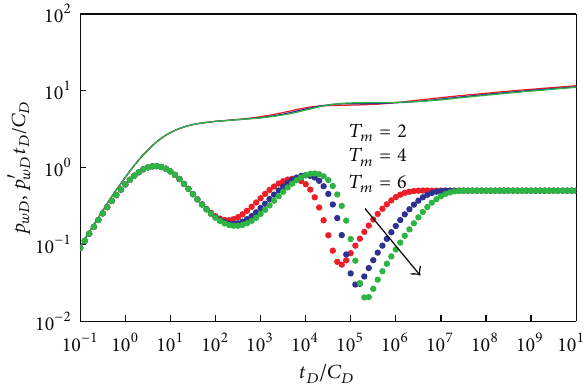
Figure 2: Pressure type curves of dual fractal reservoirs ( 𝛼 = 1 , Figure 3: Effect of pore tortuosity ( 𝑇 𝑚 ) on type curves ( 𝛼 = 1 , 𝛽 = = 10 m, 𝑑 = 0.05 m, 𝐷 = 1.5 , 𝛽 = 0.707 , 𝜃 = 1 , 𝑁 = 4 , 𝑀 = 10 , 𝑙 0.707 , 𝜃 = 1 , 𝑁 = 4 , 𝑀 = 10 , 𝑙 0 0 𝑓 = 4 , 𝑟 = 0.1 m, 𝑆 = −1 , 𝐶 = 0.0001 , ℎ = 10 m, 𝐶 = 𝑇 = 0.1 m, 𝑆 = −1 , 𝐶 𝑟 𝑚 𝑤 𝐷𝑒 𝑚𝑡 𝑤 = 1 × 10 −4 MPa −1 ). 2.2 × 10 −5 MPa −1 , and 𝐶 and 𝐶 𝑓𝑡 = 1 × 10 −4 MPa −1 ). 𝑓𝑡